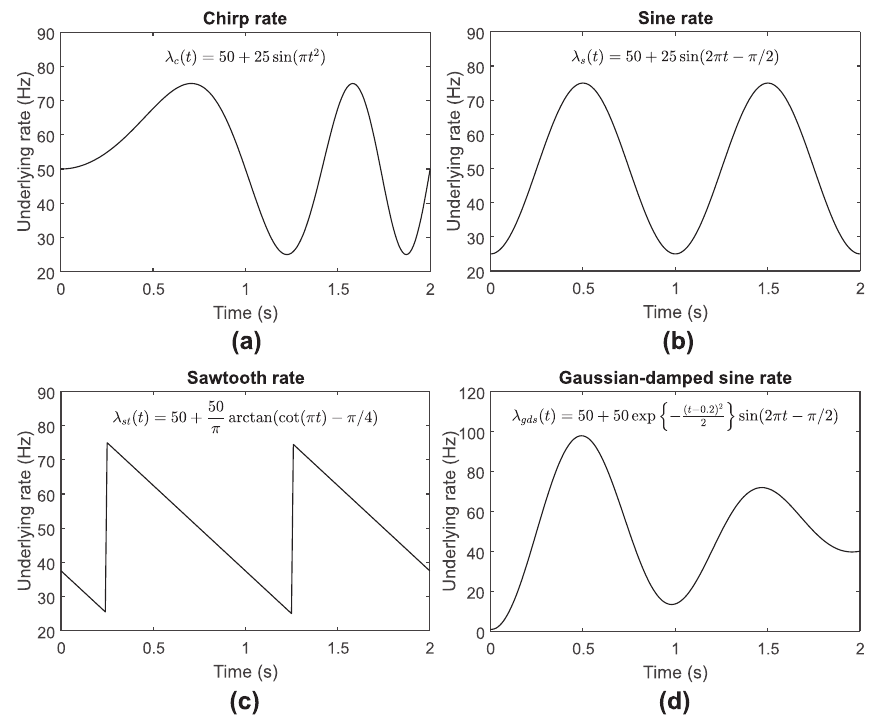
Fig 2. Illustration of the underlying rate functions used in this study. (a) Chirp rate function with η = 50, A = 25, f c = 0.5, and ϕ = 0. (b) Sine rate function with η = 50, A = 25, f s = 1, and ϕ = − π /2. (c) Sawtooth rate function with η = 50, A = 25, f st = 1, and ϕ = − π /4. (d) Gaussian-damped sinusoidal rate function with η = 50, A = 1, t 0 = 0.2, σ = 1, f gds = 0.5, and ϕ = − π